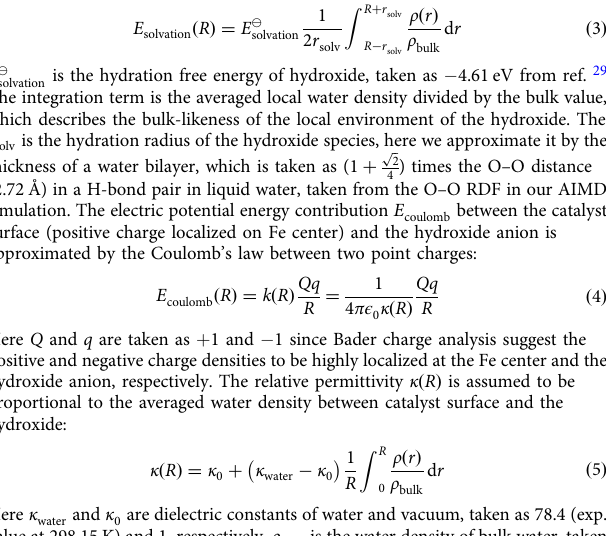
as a function of R is calculated by Here r 0 = 1.32Å. The local water density ρ H 2 O effective counting along R within the region of 1.67<CN O <3 for each subplot in Fig. 3b. The density distribution of the pseudo-adsorbed hydroxide species P(OH δ − ) as a function of R is obtained similarly based on effective counting along R within the region of CN O <1.67 and R >2.5Å (to exclude the * OH on Fe center) for each subplot in Fig.